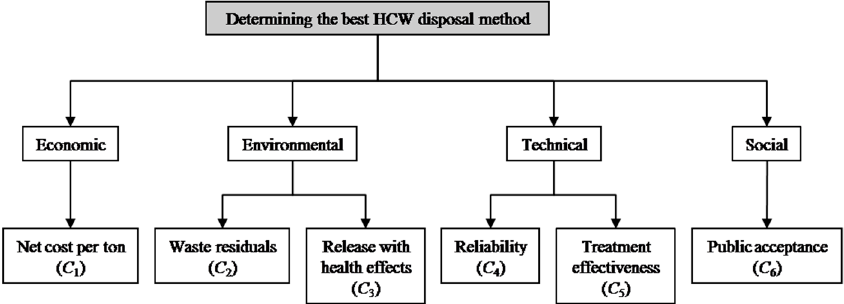
Figure 2. Hierarchical structure of the problem.